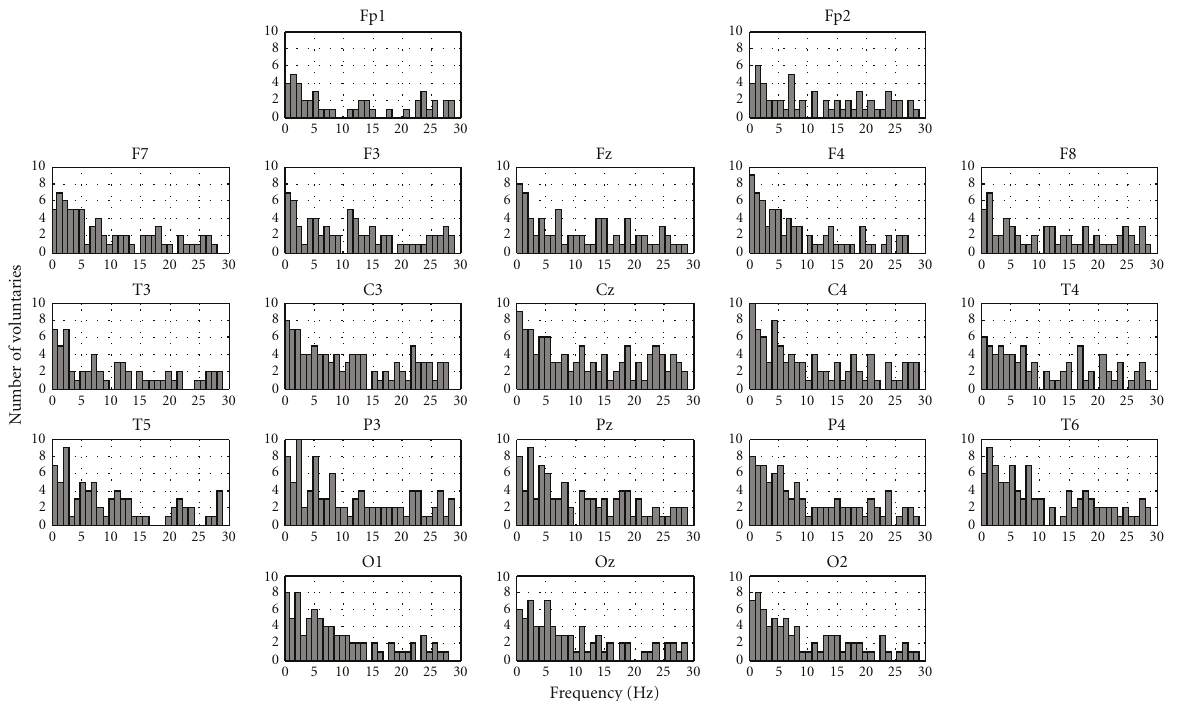
Figure 10: Histogram (bin width 1Hz) topographic distribution displaying the number of subjects with response after MSC application higher than the critical value (significance level 5%) for ERPs during left index finger movement, harmonics from 0 to 30Hz. Frequencies higher than 30 Hz did not show significant responses.